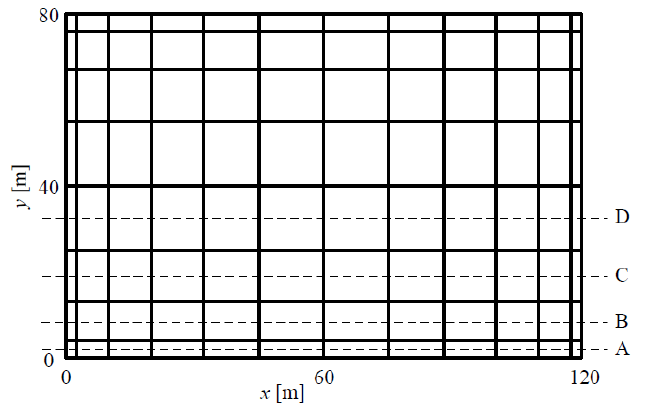
Fig. 7 Grounding grid with different spacing.